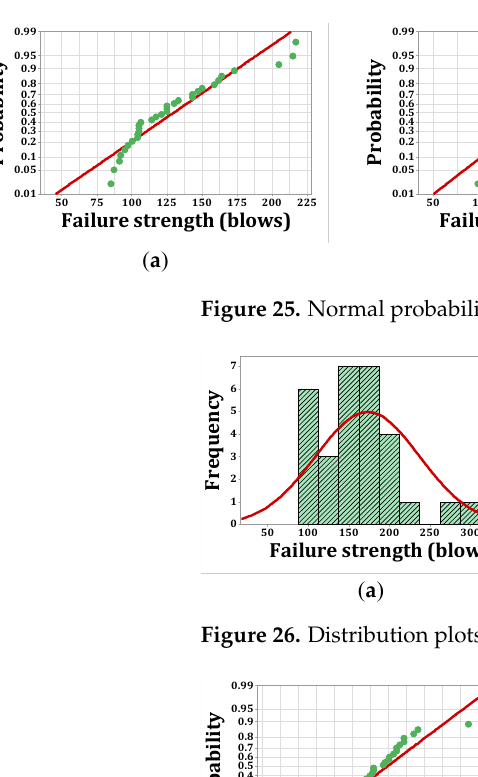
Figure 24. Distribution plots for failure strength (dry): ( a ) R, ( b ) F2, ( c ) F3.